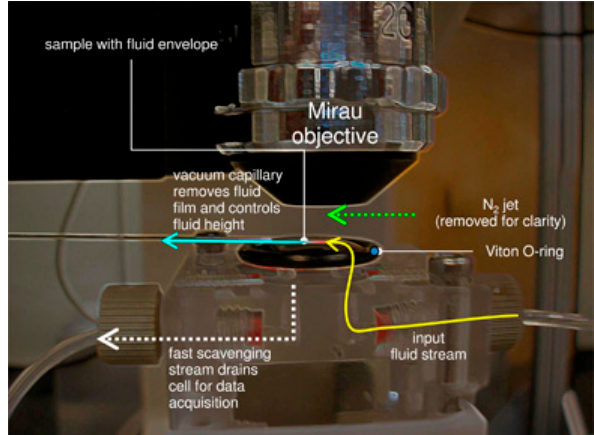
Figure 12. In-situ water–rock interaction apparatus. The crystal sample is placed within an O-ring under the objective of a vertical scanning interferometer (VSI). Inlet and outlet ports for the fluid are situated within the O-ring at opposite sides of the sample. Nitrogen (N 2 ) gas jet is direct towards the outlet port. The whole apparatus is connected to a controller that is programmed to automatically run cycles in which the sample is submerged in a reactive solution for a predetermined time interval and then rapidly dried. The drying is performed by simultaneously activating the N 2 jet, directed to push the solution towards the outlet port, and applying vacuum suction. The dried surface is then imaged. Figure reprinted from Luttge and Arvidson [147] with permission from Wiley.